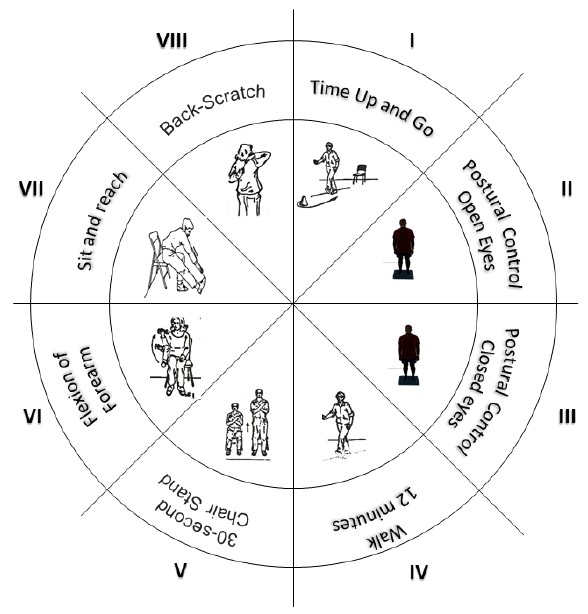
Figure 3. Assessments for physical fitness measurements.